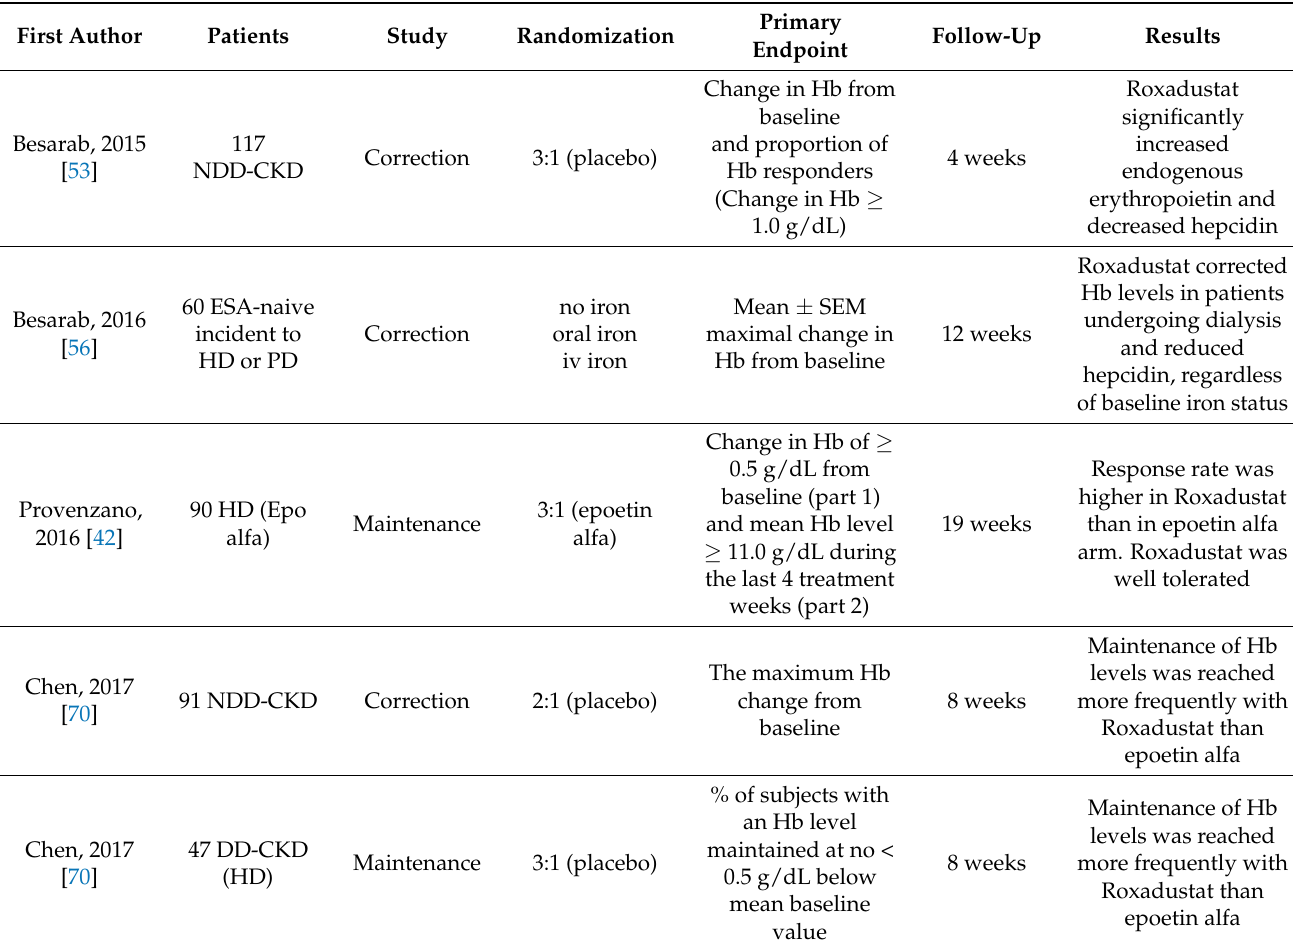
Table 1. Phase 2 studies of Roxadustat.